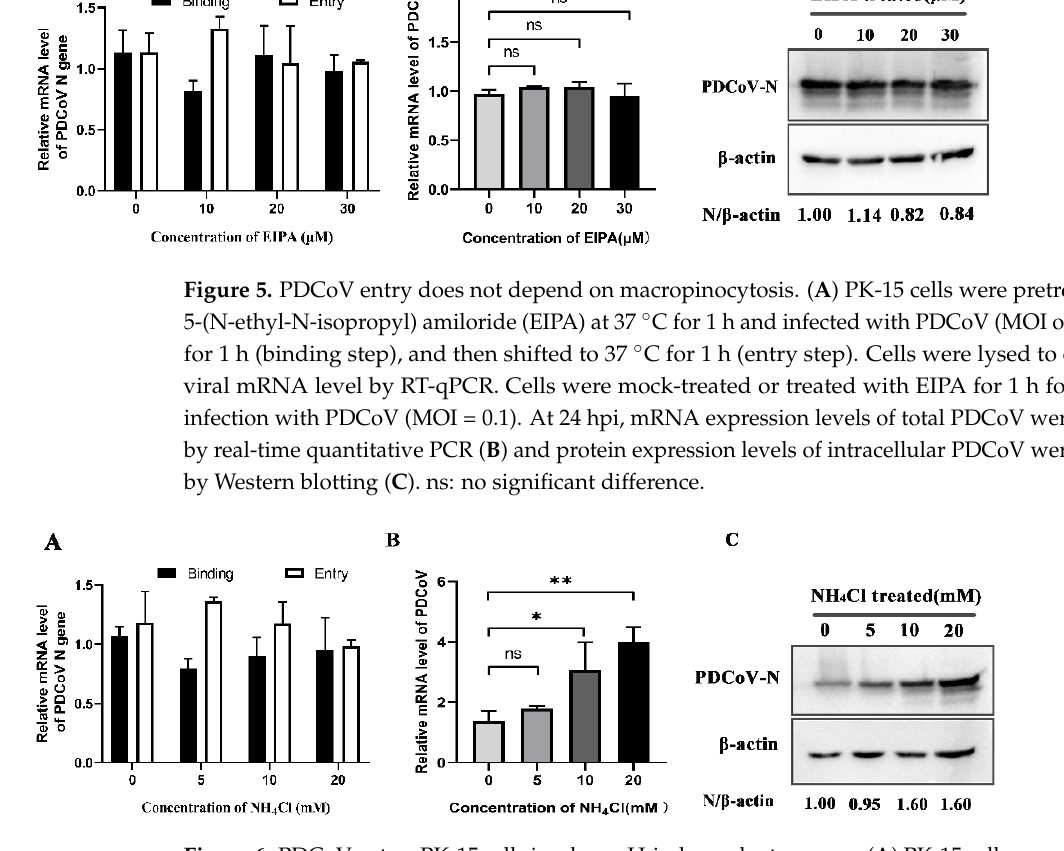
Figure 5. PDCoV entry does not depend on macropinocytosis. ( A ) PK-15 cells were pretreated with 5-(N-ethyl-N-isopropyl) amiloride (EIPA) at 37 °C for 1 h and infected with PDCoV (MOI of 5) at 4 °C for 1 h (binding step), and then shifted to 37 °C for 1 h (entry step). Cells were lysed to determine viral mRNA level by RT-qPCR. Cells were mock-treated or treated with EIPA for 1 h followed by infection with PDCoV (MOI = 0.1). At 24 hpi, mRNA expression levels of total PDCoV were detected by real-time quantitative PCR ( B ) and protein expression levels of intracellular PDCoV were de- tected by Western blotting ( C ). ns: no significant difference.